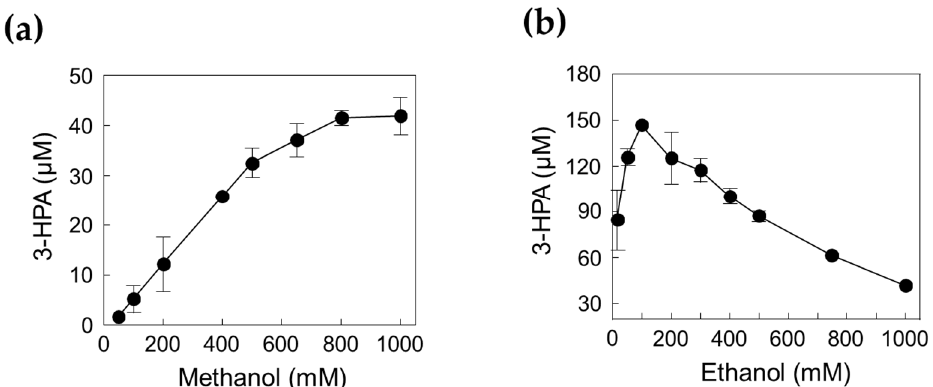
Figure 6. Effect of substrate concentration for 3-HPA production. ( a ) Effect of methanol. ( b ) Effect of ethanol. The reactions were performed in 20 mM Kpi buffer (pH 7.4) containing 1.39 U/mL DERA Tma , 0.026 U/mL MDH Lx , 5 mM Mg 2+ , and 3 mM NAD + with methanol or ethanol at 45 °C for 120 min. Data represent the means of two separate experiments, and the error bars represent the standard deviation.